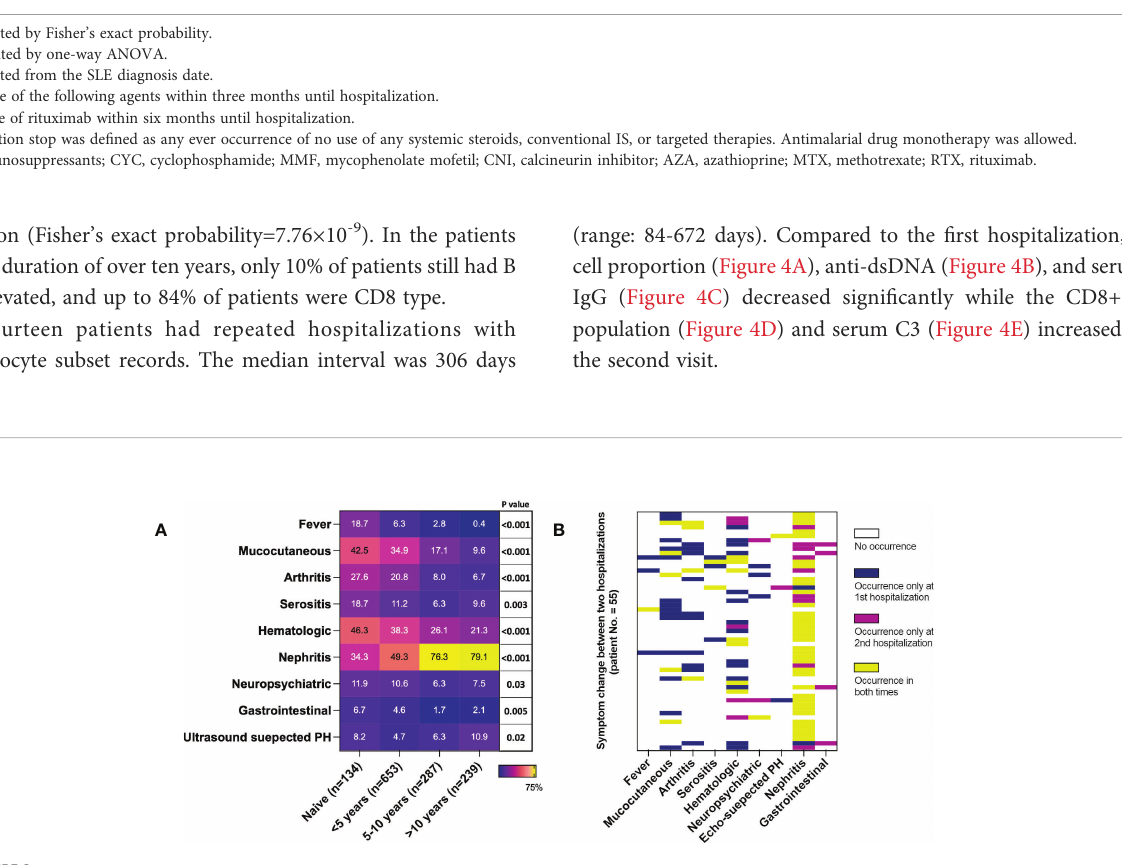
FIGURE 2 Duration biased clinical phenotype distribution in active SLE. 1313 cases were included. (A) Presence of SLE manifestations in groups of different disease durations. Each cell represents the occurrence of one symptom in the duration group in percentage. P values were calculated by the Cochran-Armitage trend test for each manifestation. (B) Changes in clinical manifestations of 55 patients with repeated hospitalizations due to active lupus (both hospitalizations with SLEDAI ≥ 8). PH, pulmonary hypertension.